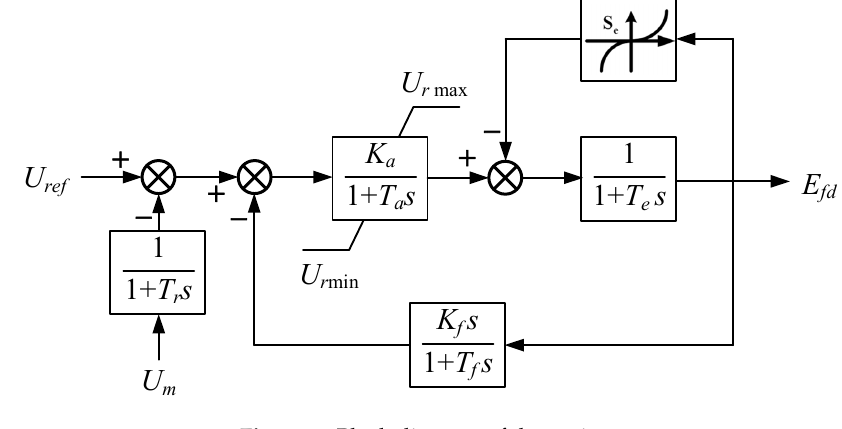
Figure 6. Block diagram of the exciter.